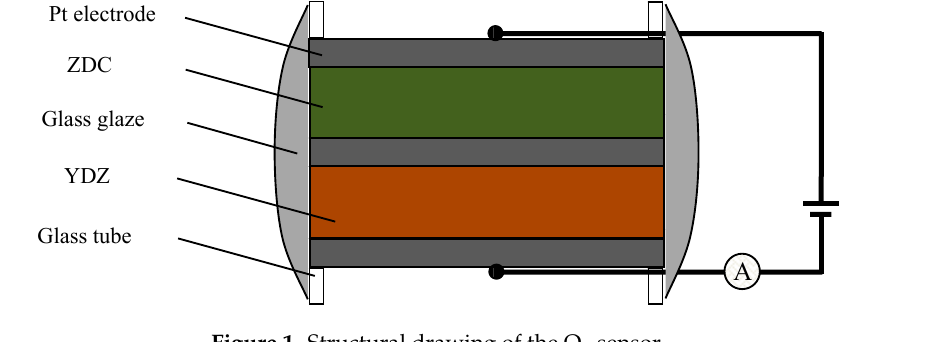
Figure 1. Structural drawing of the O 2 sensor.